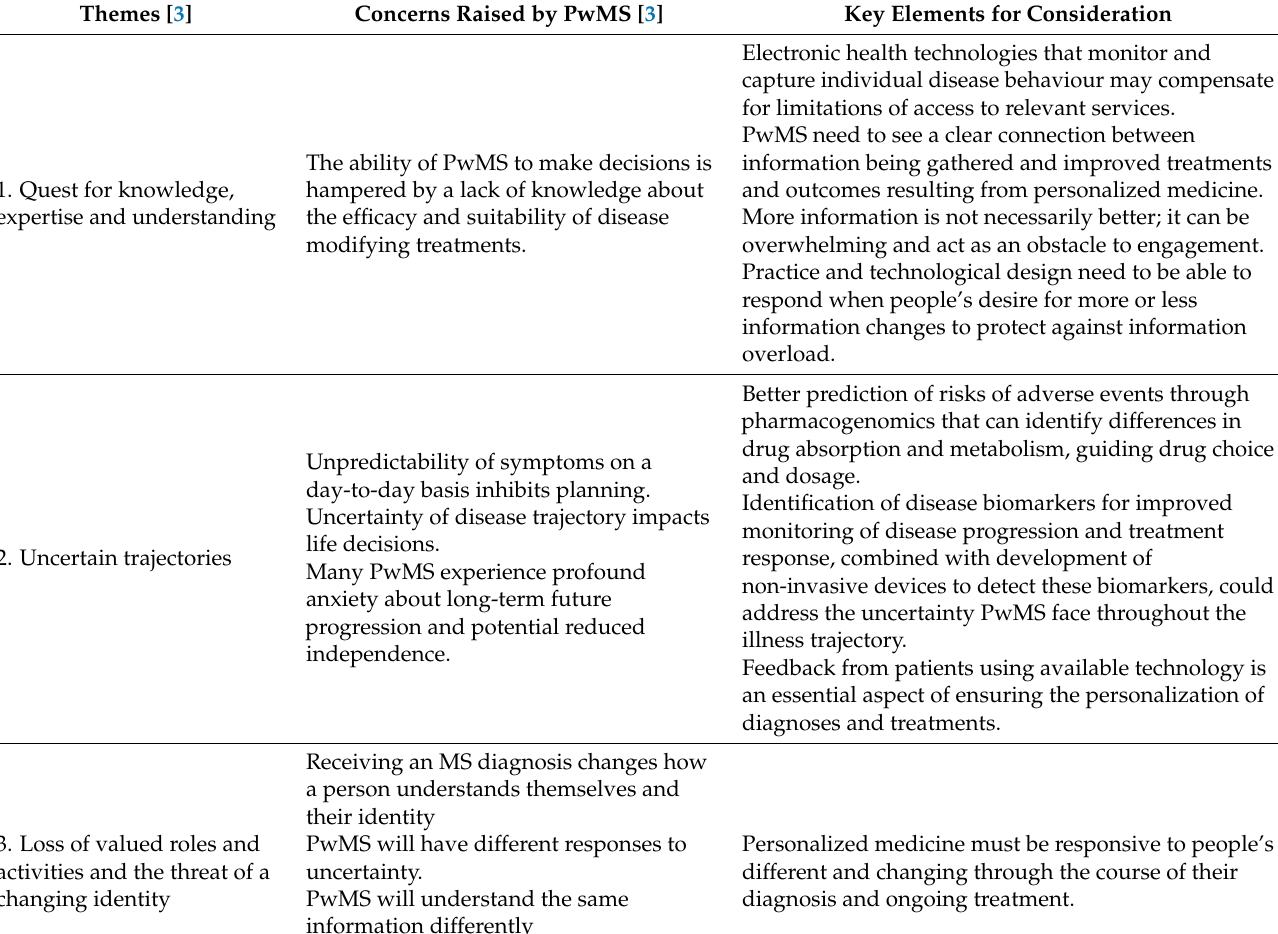
Table 1. A summary of issues of concern for PwMS [3] and related elements for consideration in the development of personalized medicine and